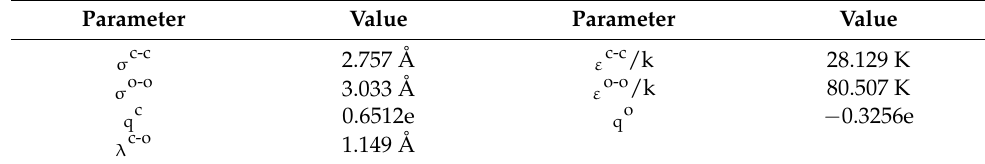
Table 2. Molecular parameters for carbon dioxide. Parameter